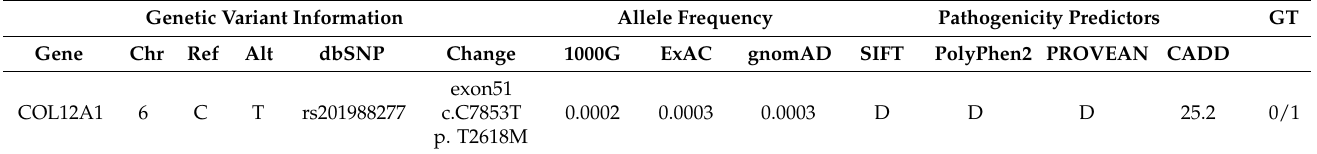
Table 4. Description of a variant candidate identified with the ANNOVAR tool in the index